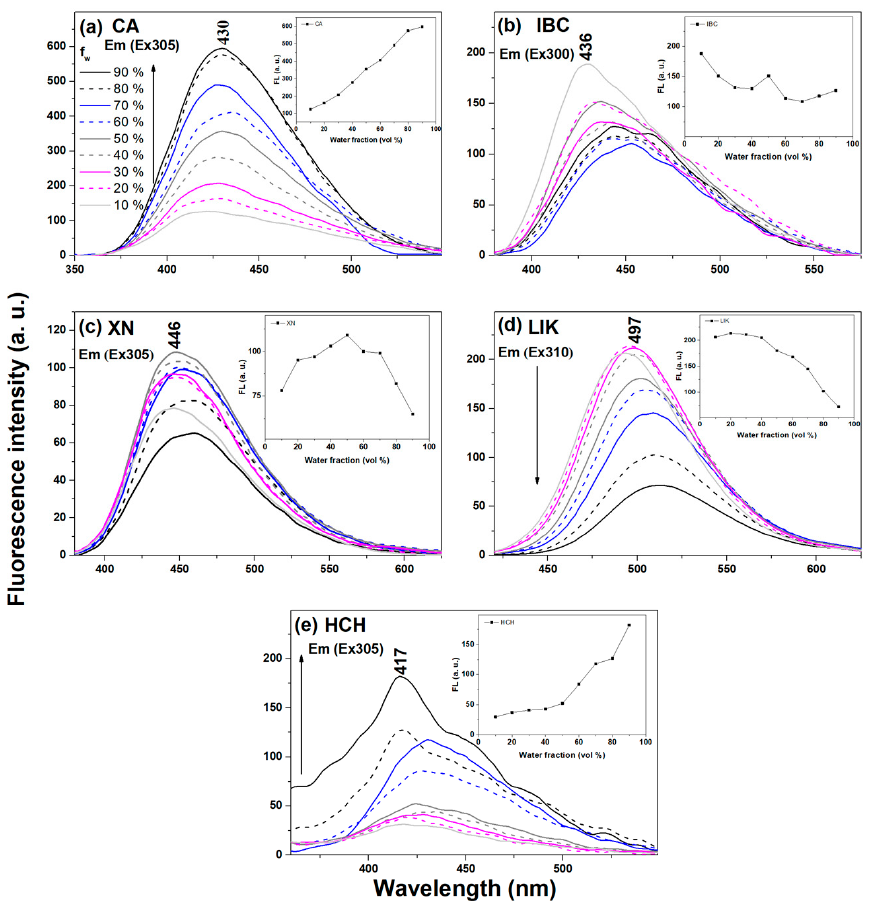
Figure 3. Fluorescence emission spectra of chalcones in various MeOH:H 2 O proportions. The excitation was set at the fluorescence emission maximum of each sample, as pointed out in the figure. The insert shows the relationship between the maximum fluorescence intensity and the water fraction. (Ex